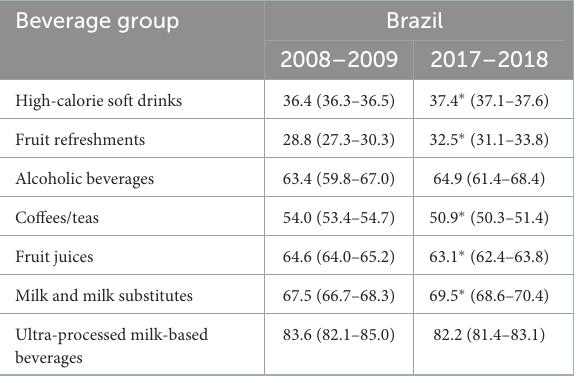
TABLE 4 Energy density (kcal/ml) and 95% confident interval (95% CI) of beverages groups, in 2008–2009 and